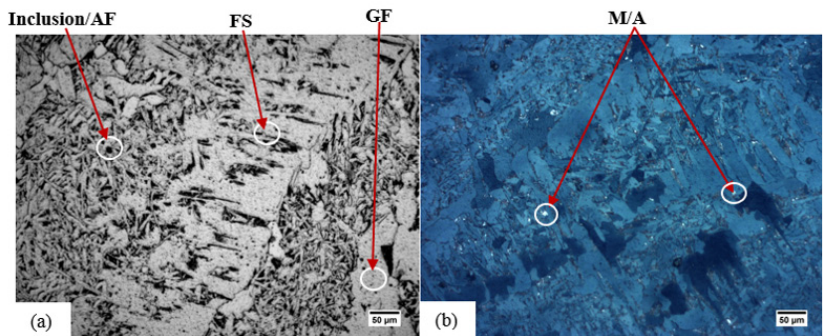
Figure 6: Optical microstructure characterization of weld metal (WM) for S-SAW. (a) 2% Nital etching and (b) Klemm I etching.